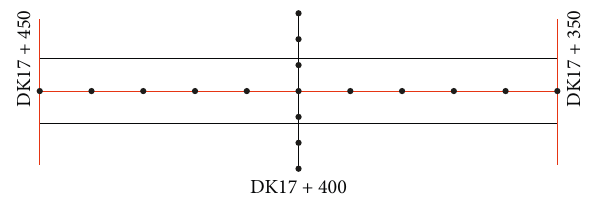
Figure 13: Monitoring sections and points from DK17 +350 to DK17 +450.